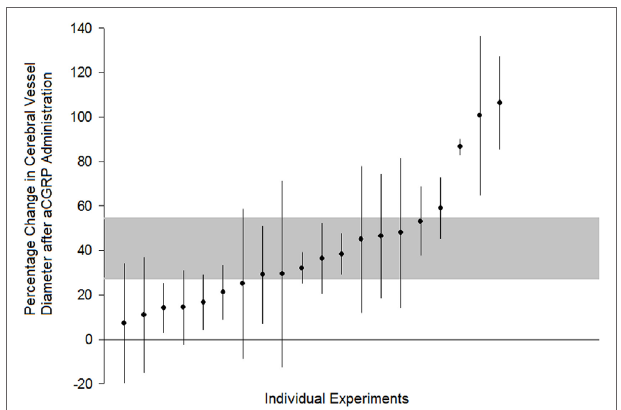
FiGURe 2 | Comparison of individual experiments ranked according to the effect of alpha calcitonin gene-related peptide on change in cerebral vessel diameter. Vertical error bars represent 95% confidence intervals for the individual estimates while the gray area represents the 95% interval for the grouped (all studies) estimate. Percentage change is in comparison to post-subarachnoid hemorrhage diameter or control values, depending upon how the original publication reported